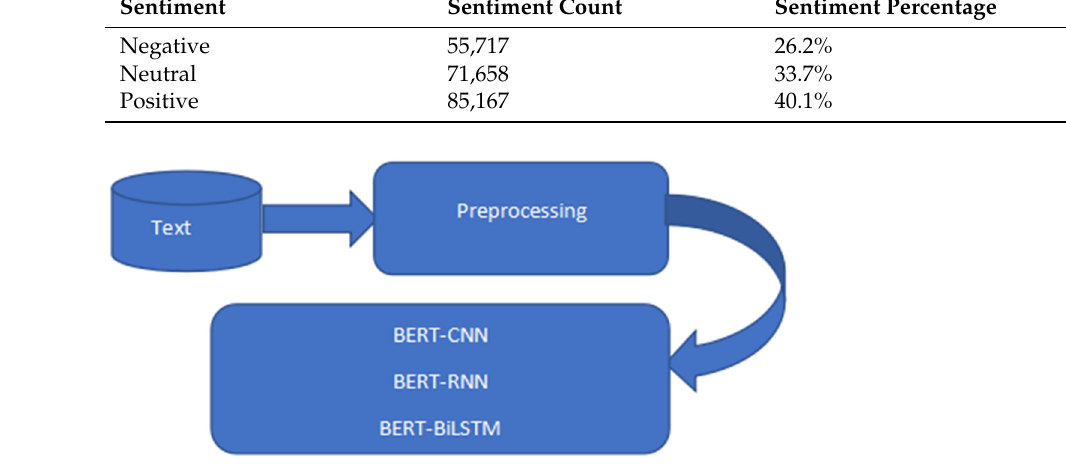
Figure 1. BERT-based architecture. Figure 1 . BERT-based architecture .